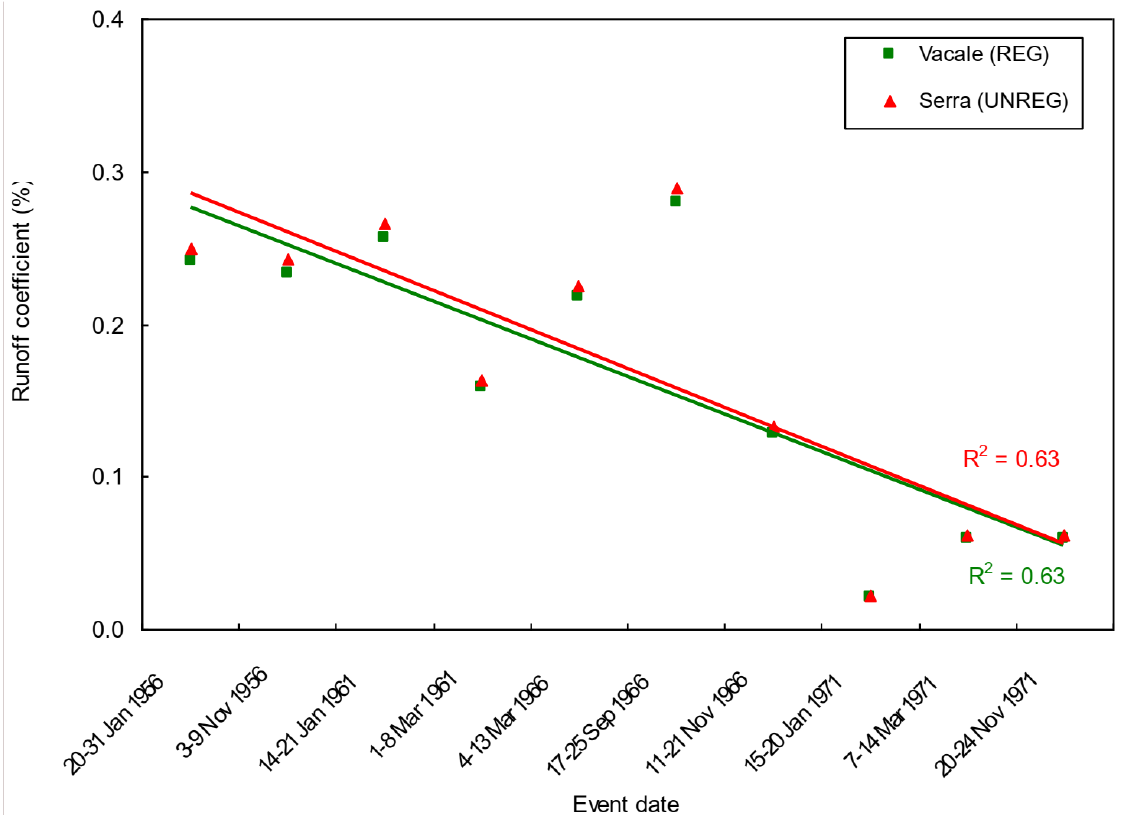
Figure 8. Temporal evolution of runoff coefficients in unregulated (UNREG) and regulated (REG) sub-catchments (Calabria, Southern Italy)—events are not reported on the time